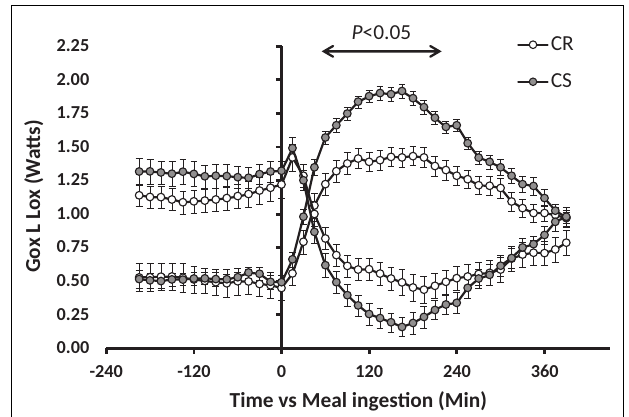
FIGURE 1 | Meal-induced changes in glucose and lipid oxidation after ingestion of a low-fat high carbohydrate test meal in CR and CS rats . This figure has been drawn with data taken from the experiment previously published in Nadkarni et al. (17).